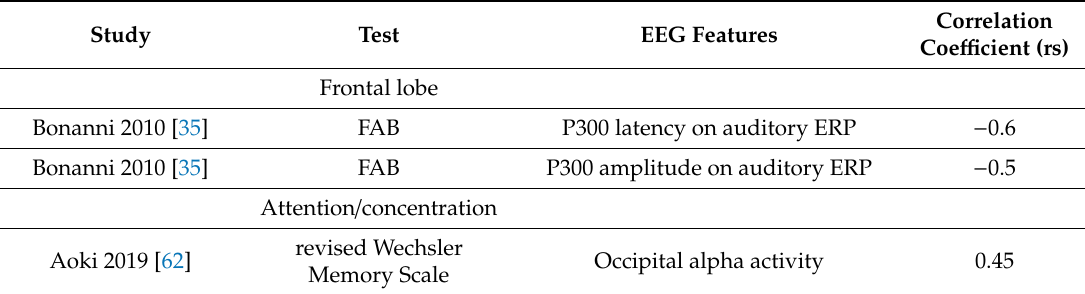
Table 5. Correlation of EEG features with domains of cognitive